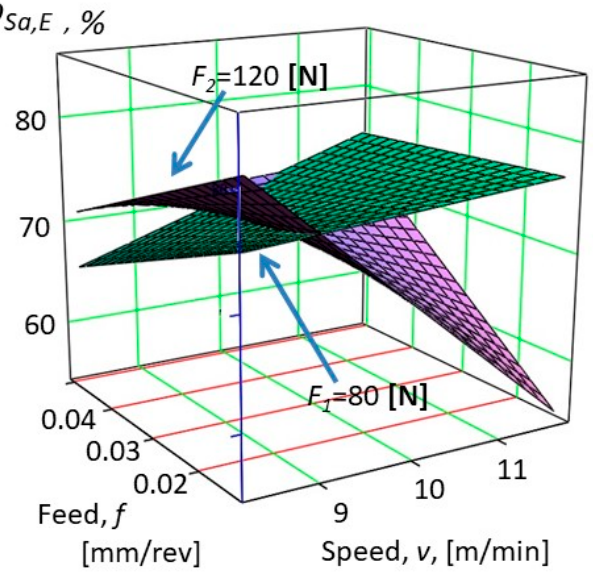
Figure 15. Improvement of the change of surface roughness ρ Sa , E on specimens marked E (see Equation (13)).